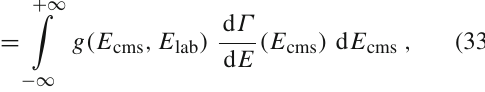
Fig. 11 The response function R ( E , qU ) at a retarding energy of qU = 18 , 545 eV. The dash-dotted and dashed curves show the response function close to the front (spectrometer-facing, z = + 4 m) vs. rear ( z = − 4 m) of the WGTS, which has a length of 10 m in total. An averaged version, weighted by the gas density in each source segment, is shown as the solid curve